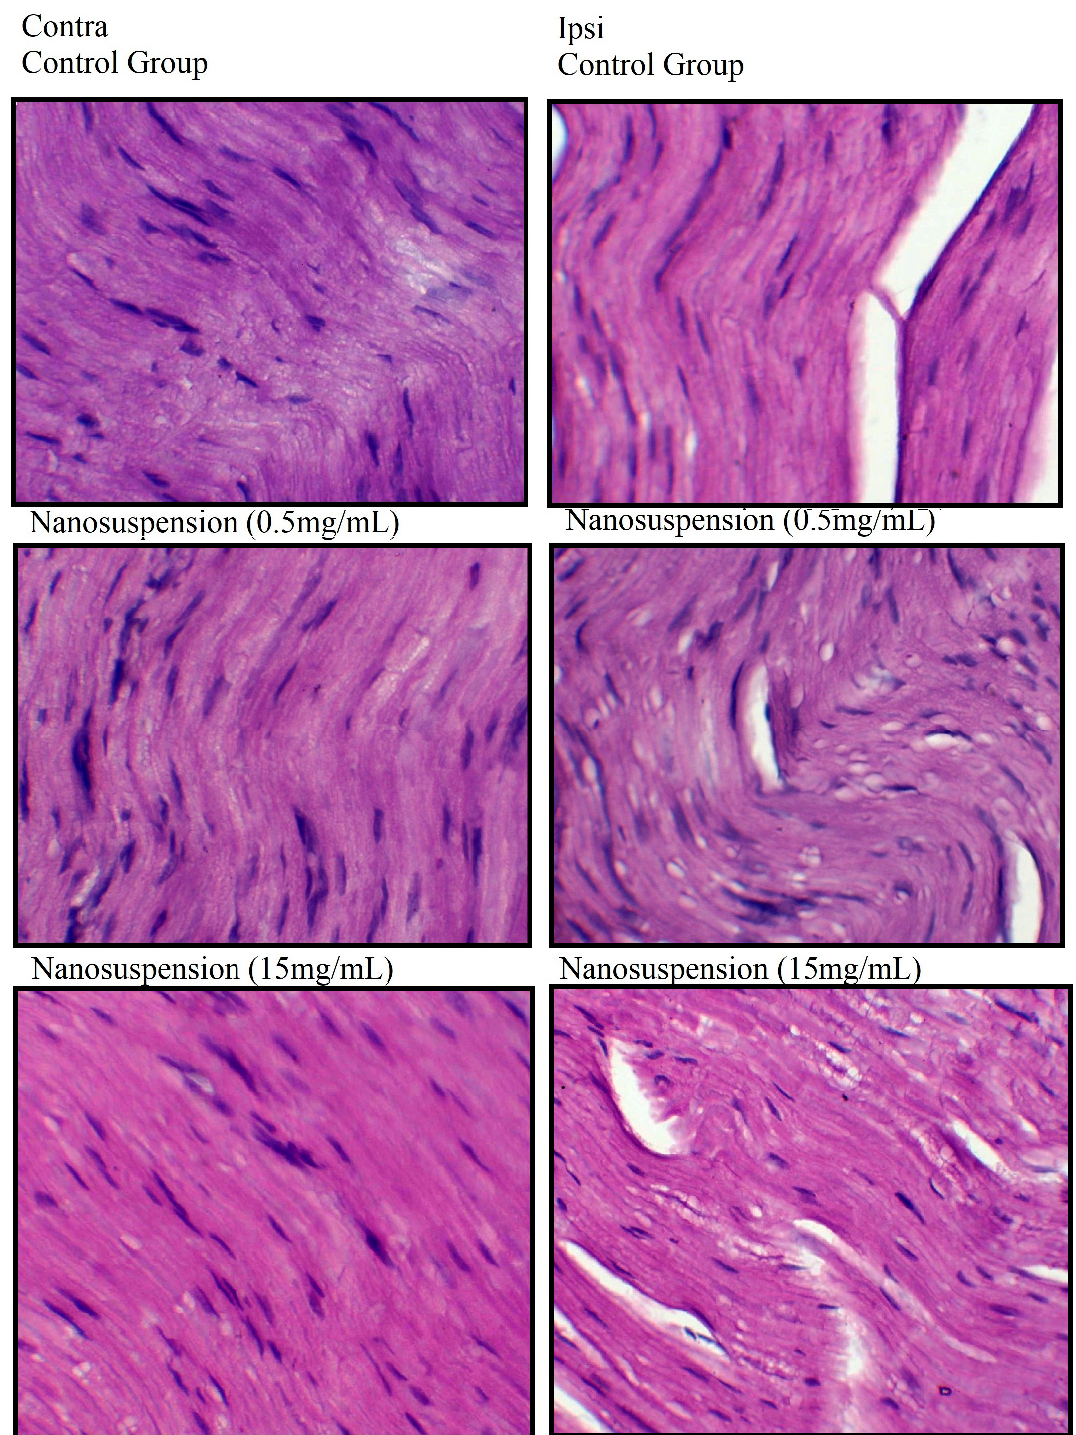
Figure 8. Impact of F. vulgare on muscular histology (Images taken as 40× magnification).